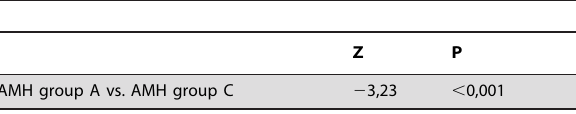
Table 5. Mann-Whitney test for comparison between poor responders and high